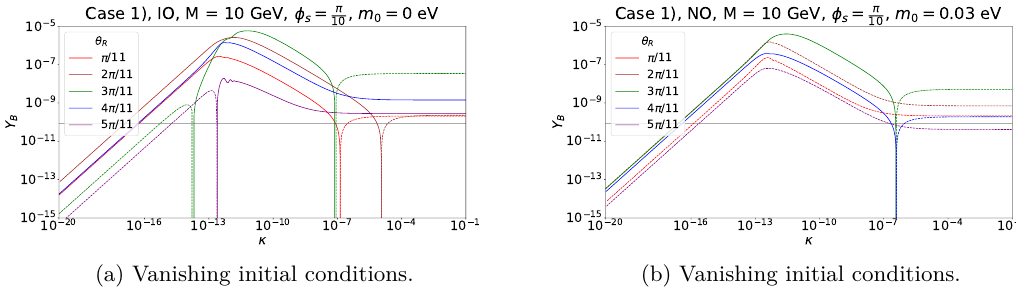
Figure 5 . Case 1) Y B as function of κ for M = 10 GeV for light neutrino masses with strong IO (left plot) and for light neutrino masses with NO, but non-zero m the remaining choices see figure